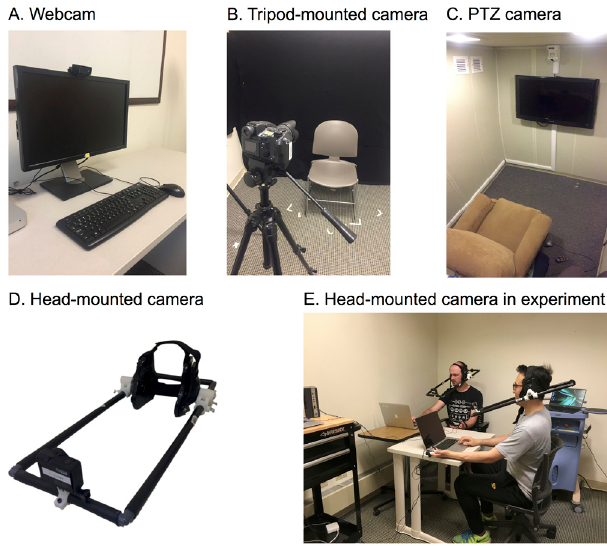
Figure 1. Different recording setups. ( A ). Webcam setup with a camera positioned above the monitor. ( B ). Tripod-mounted camera setup placed facing the subject. ( C ). PTZ camera setup with the camera installed above the TV screen in a dedicated room. ( D ). Head-mounted camera built according to build instructions in the Underlying data . ( E ). Use of head-mounted camera in social interaction